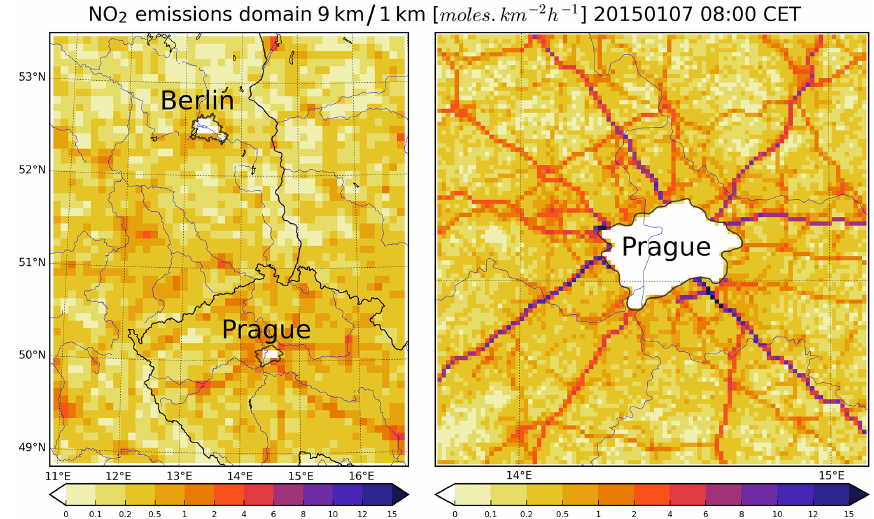
Figure 2. Demonstration of the masked NO 2 emissions for Prague and Berlin for the 9 and 1km domains (in molkm − 2 h − 1 ) (only a part of the domains is shown).